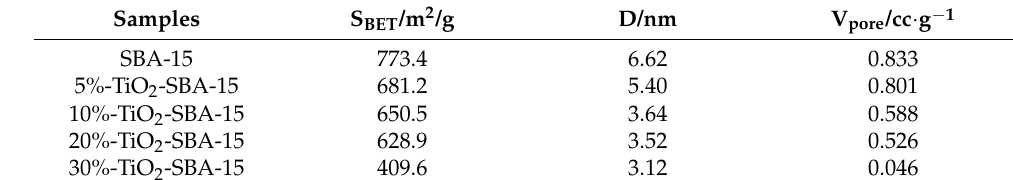
Figure 3. ( a ) XRD patterns of different TiO 2 loading amounts, ( b ) SAXS plots of different TiO 2 loading amounts. Table 1. Sample specific surface area and pore size for SBA-15 and different TiO 2 loading amounts. Samples